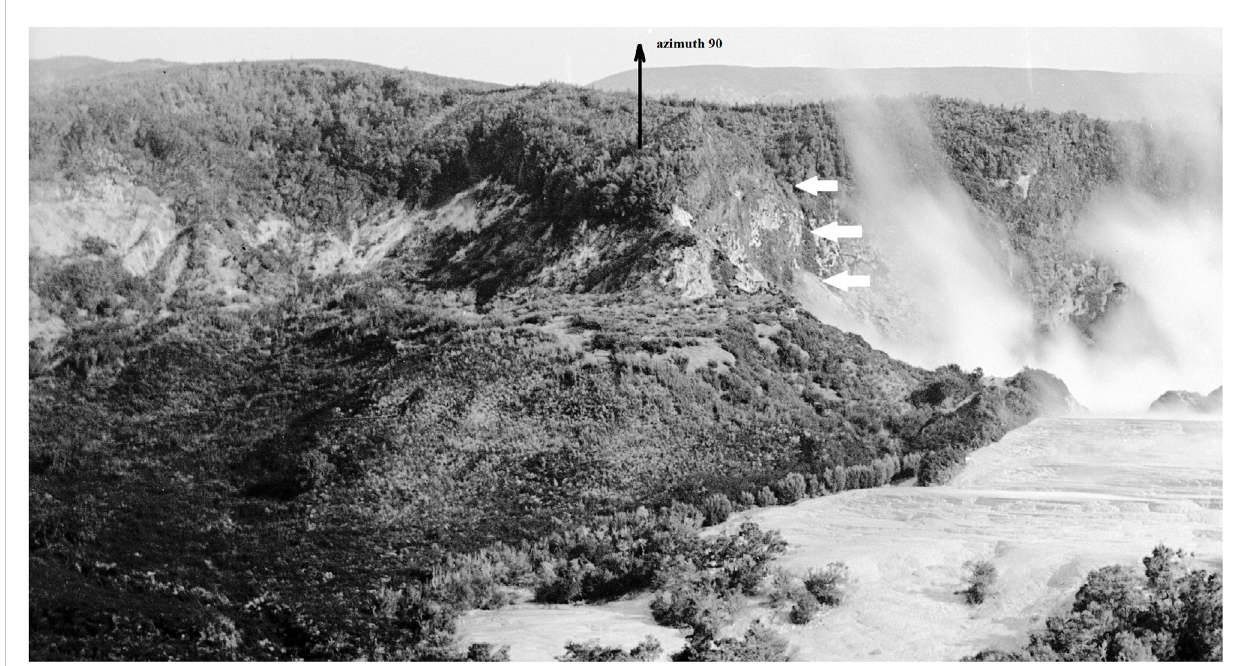
FIGURE 18 Fretted northern embankment of the White Terraces (Te Tarata), arrowed looking east with Orangiaho to the north. White Terrace, Rotomahana, (cropped) by Burton Brothers, Alfred Burton (Te Papa